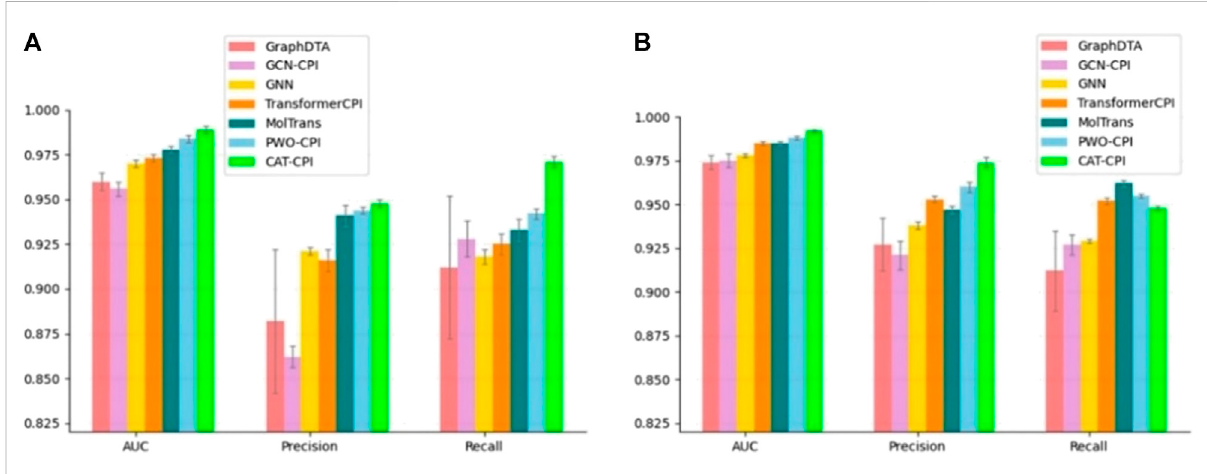
FIGURE 3 Comparison of CAT-CPI and other deep learning methods on Human (A) and Celegans (B) datasets.